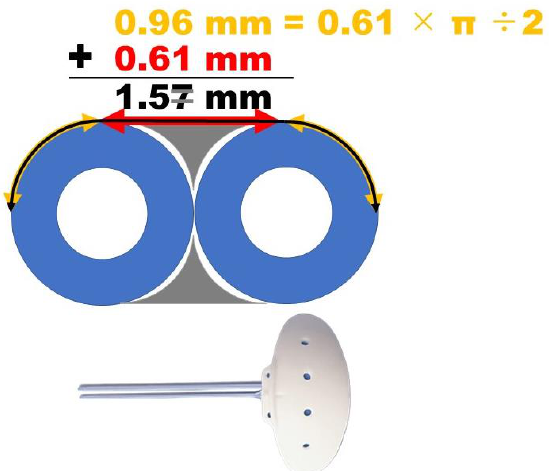
Figure 2. Calculation of the width of two tubes placed side by side; The outer diameter of the tube is 0.61 mm, and when two tubes are placed side by side, their width is 1.22 mm, and the half of the outer circumference calculated to be 1.57 mm. The hypothetical gap when the tubes are placed in the scleral tunnel is indicated in gray.